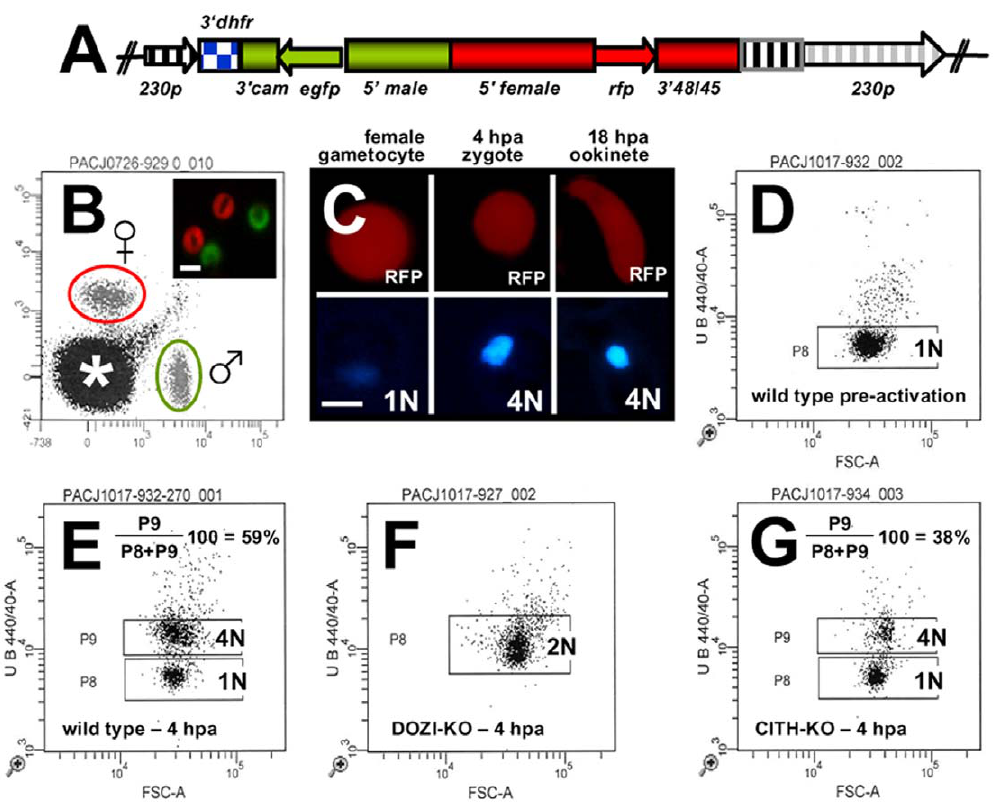
Figure 4. Zygotes formed by D pbcith and D pbdozi gene deletion mutants abort zygote to ookinete transformation. A Schematic representation of the vector used to introduce the gfp/rfp male/female expression cassette into the p230p locus. B Identification of populations of RFP + female gametocytes and GFP + males by FACS in blood infected with parasites of line 820cl1m1cl1. Gametocyte populations are clearly separated from the population of red blood cells and red blood cells infected with the asexual bloods stages (asterisk). The inset shows male (GFP + ) and female gametocytes (RFP + ). Scale bar =4 m m. C RFP and Hoechst 33258 staining of female gametocyte, zygote and ookinete of line 820cl1m1cl. Zygotes and ookinetes were collected at 4 hours post activation (hpa) and 18 hpa, respectively. Note the increased Hoechst fluorescence intensity of the nuclei of zygotes and ookinetes as a result of fertilization and meiotic DNA replication, resulting in tetraploid nuclei. Scale bar =2 m m. D and E FACS analysis of Hoechst fluorescence intensity of wild type female gametes (D) and zygotes (E). In (D) haploid female gametes are shown before fertilization and (E) shows unfertilized females (1N) and tetraploid zygotes (4N) collected at 4 hpa. F D pbdozi females are fertilized as shown by the doubling in DNA content, but do not achieve tetraploidy. G Females of D pbcith mutants develop into tetraploid